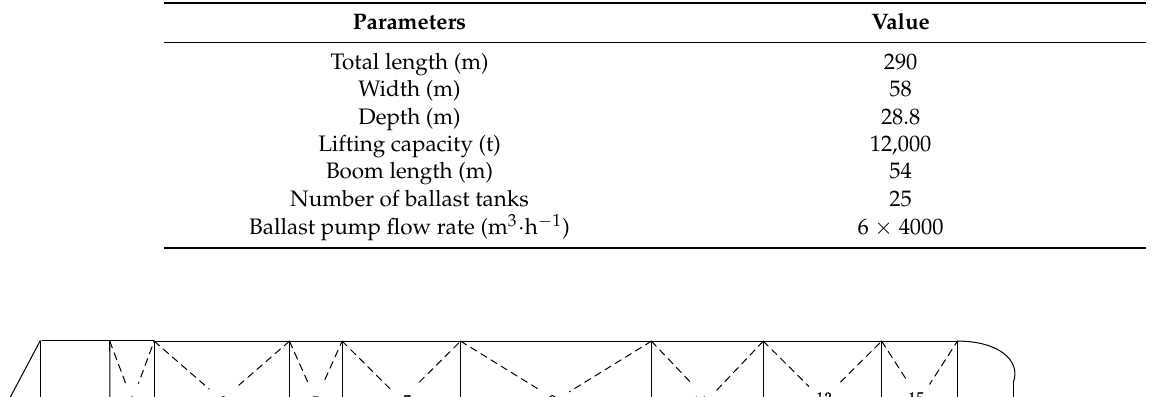
Table 5. Main parameters of the RFC with 25 ballast tanks.